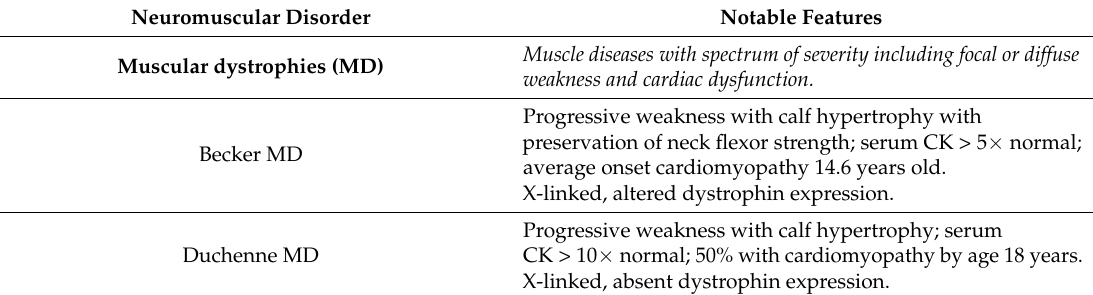
Table 1. Overview of the most common muscular dystrophies and mitochondrial disorders with specific anesthetics implications and notable features for each